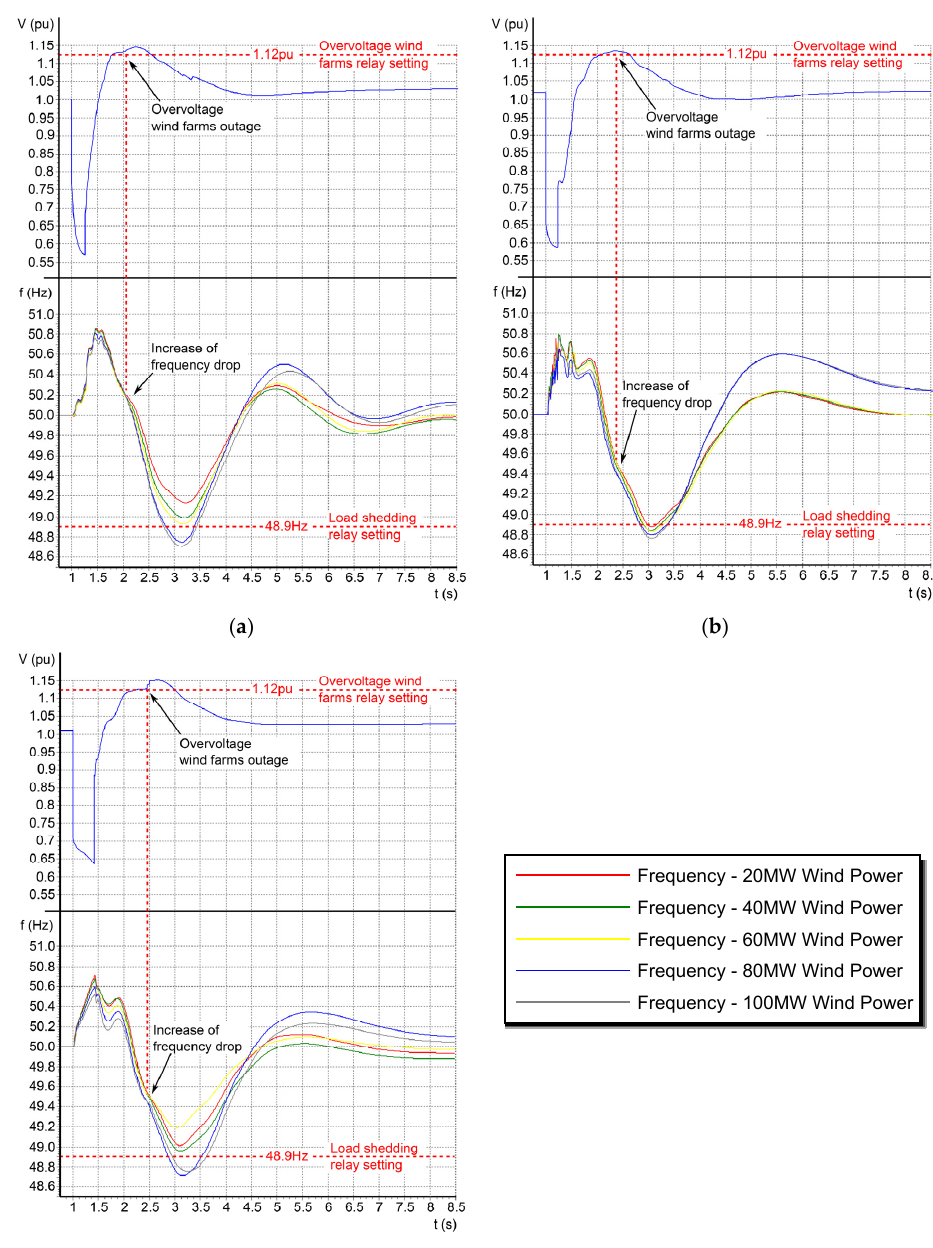
Figure 10. Time evolution of voltage and frequency for a three-phase short circuit at: ( a ) Las Salinas substation, with 260 ms of clearing time and an SCIG wind turbine; ( b ) Punta Grande substation, with 230 ms of clearing time and a full converter wind turbine; and ( c ) Haría-Teguise, with 420 ms of clearing time with a full converter wind turbine and with inertia emulation